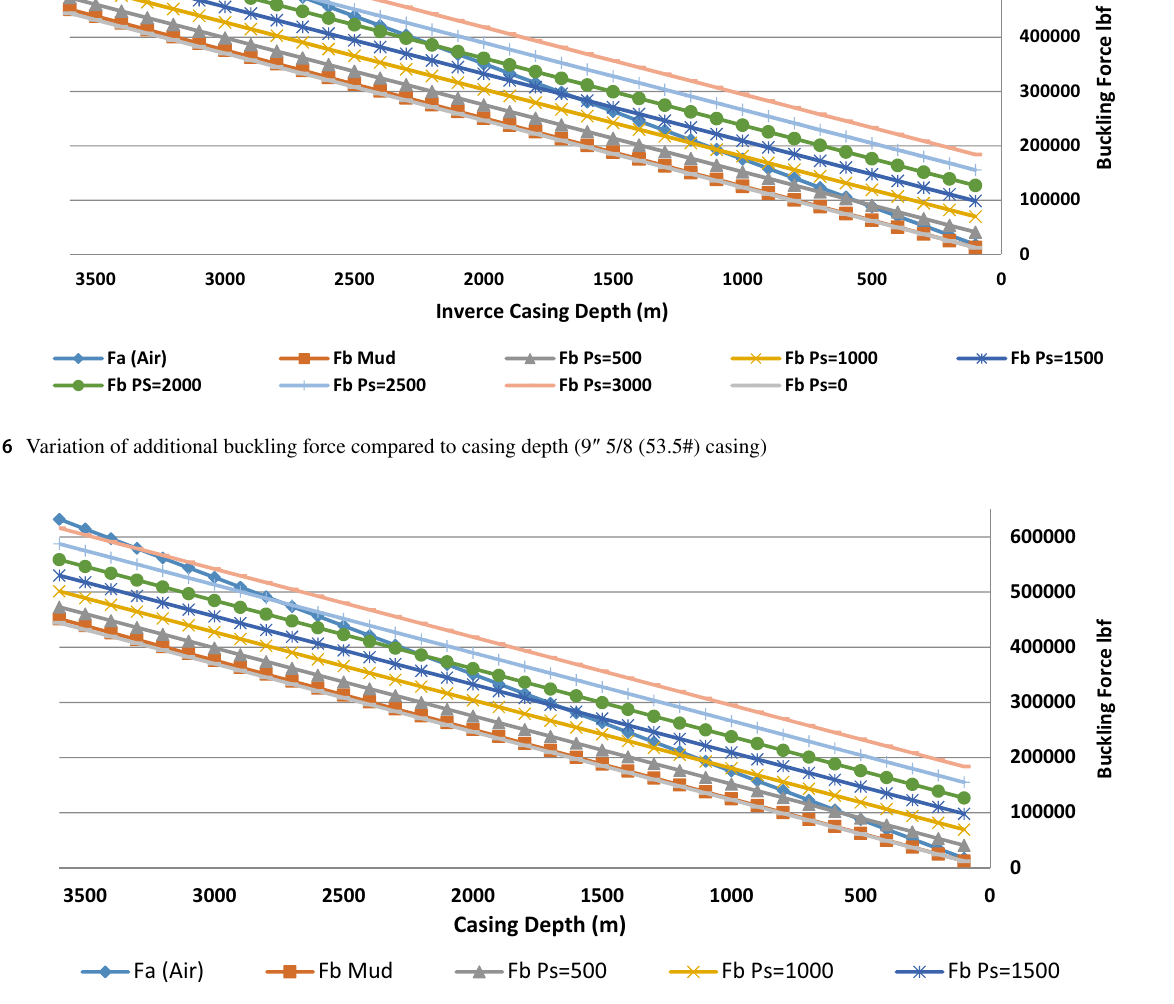
Fig. 7 Variation of additional buckling force compared to casing depth (9 ″ 5/8 (61.1#) casing) Table 2 Maximum allowable surface pressure for 9 ″ 5/8 cement job 9 ″ 5/8 Casing